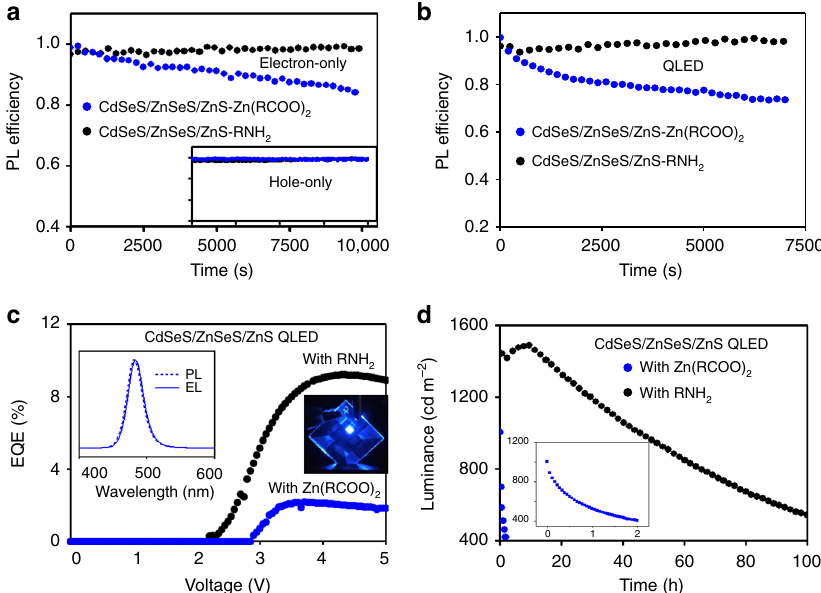
Fig. 5 Electrochemical stability and QLED performance of the blue-emitting QDs. a Relative PL ef fi ciency of the QDs in the electron-only devices (ITO/ TPBi (~25 nm)/QDs (~20nm)/Zn 0.9 Mg 0.1 O (~50nm)/Al) driven at a constant current density of 100 mA cm − 2 . Inset, the relative PL ef fi ciency of the